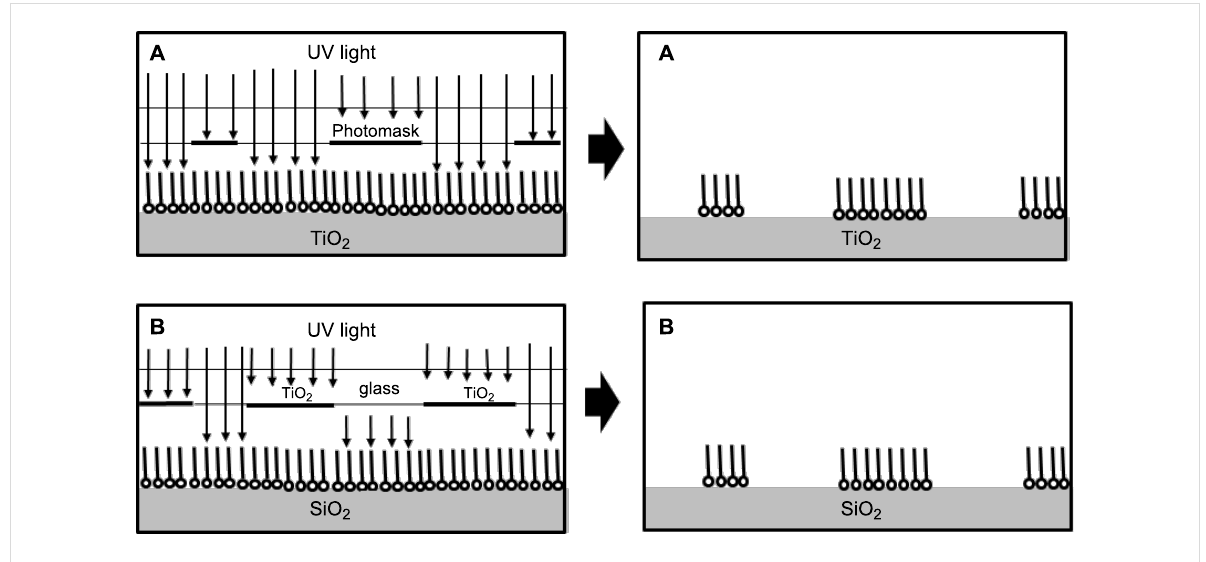
Figure 3: Photocatalytic patterning of SAMs. (A) SAMs on TiO 2 (B) SAMs on inert substrates.